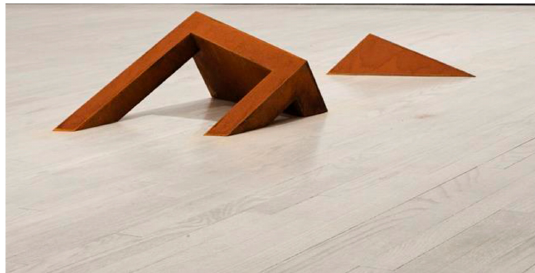
Figure 6. Micha Ullman, Under (detail), 2009. Iron and red sand. Chair: 27 cm × 45cm × 43 cm, 12 parts, varying sizes. Photograph: Micha Ullman.